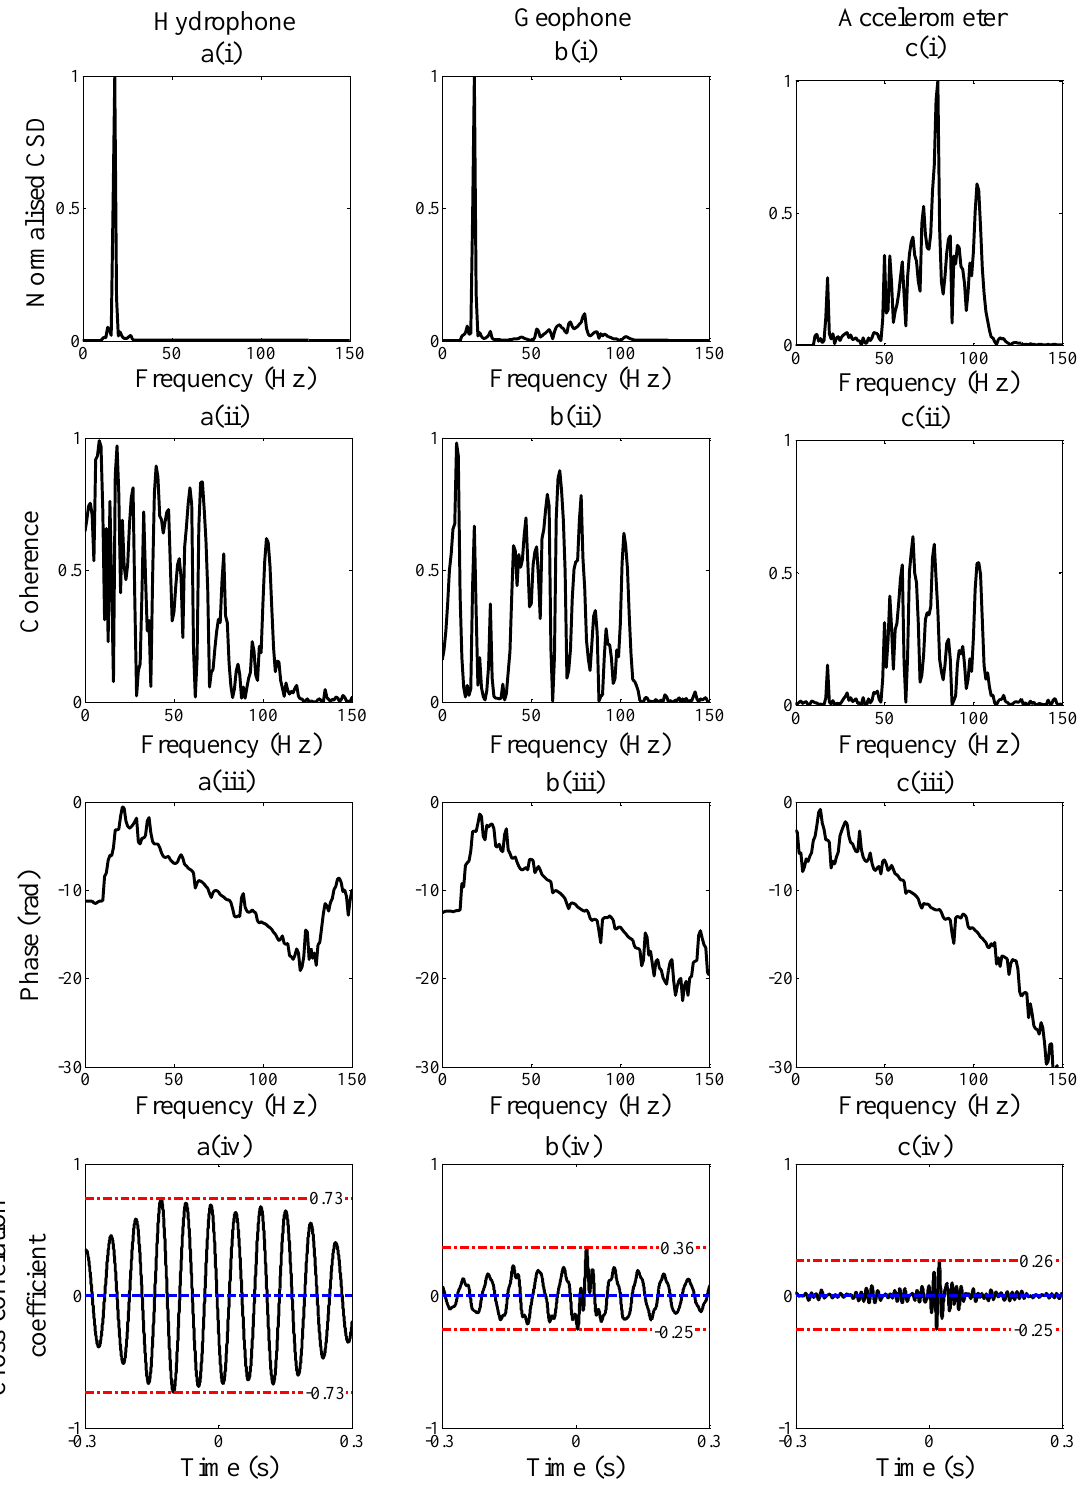
Figure 6. Analysis of the weak leak data from the test-rig. ( a ) Hydrophone; ( b ) Geophone; ( c ) Accelerometer. (i), Normalized CSD with respect to the maximum amplitude between 10 Hz and 150 Hz. (ii) Coherence. (iii) Phase. (iv) Cross correlation